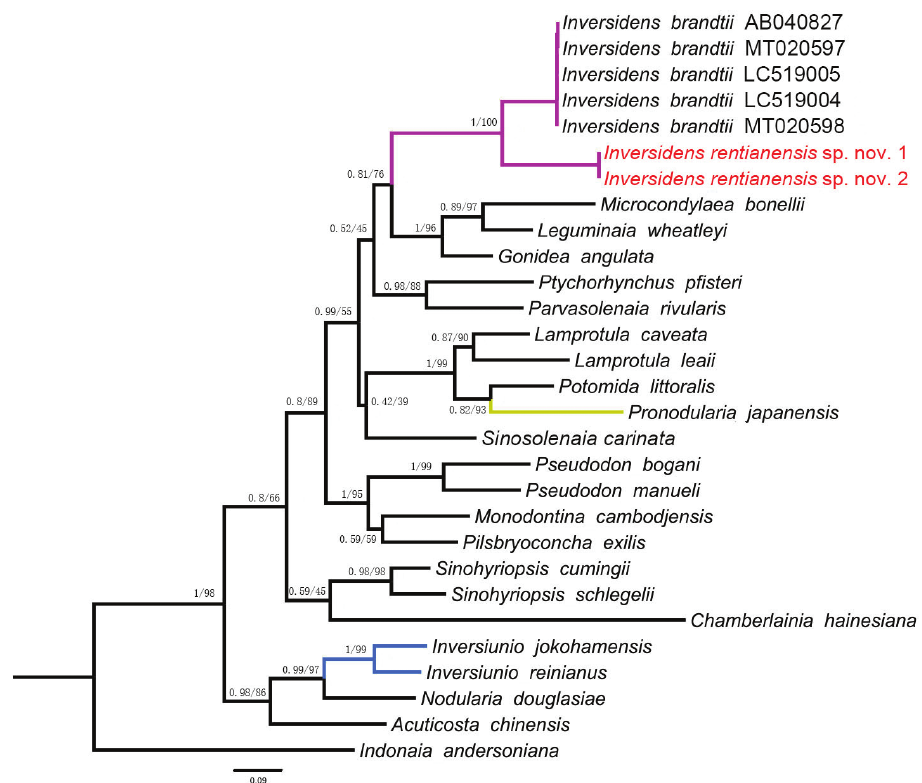
Figure 3. Phylogenetic tree of freshwater mussels inferred from Bayesian Inference (BI) and Maximum Likelihood (ML) analyses of COI barcode. Support values above the branches are posterior probabilities (PP)/bootstrap support (BS). Red font indicates the new species from this